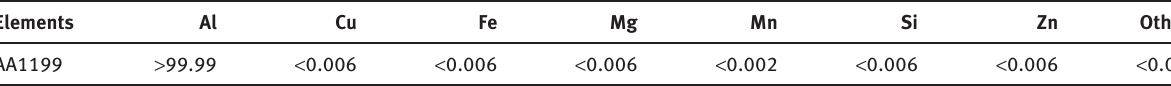
Table 1: Chemical composition of pure aluminum grade AA1199. Elements